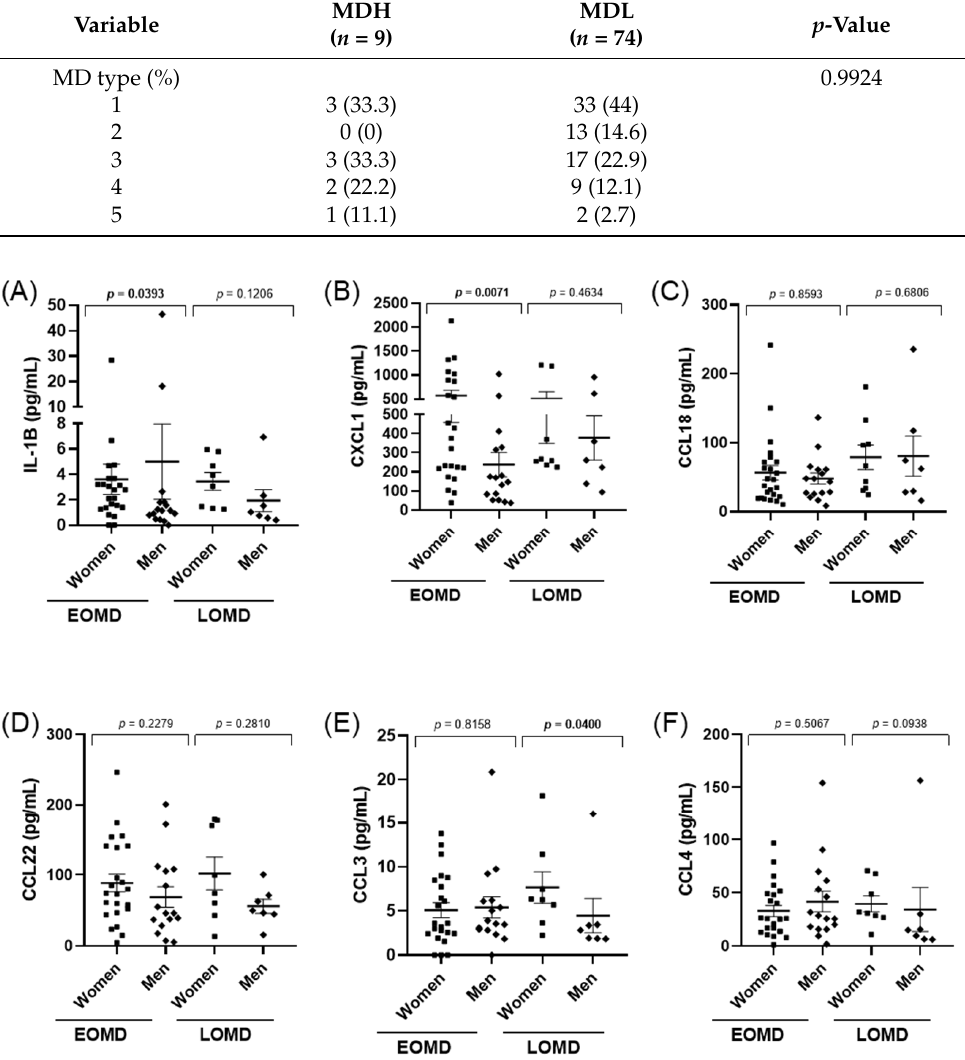
Figure 1. Scatter plots showing medians and IQRs for IL-1 β ( A ), CXCL1( B ), CCL18 ( C ), CCL22 ( D ), CCL3 ( E ), CCL4 ( F ), levels measured in PBMC’s supernatant in patients with EOMD and LOMD. Cytokine and chemokine levels were compared between men and women by the